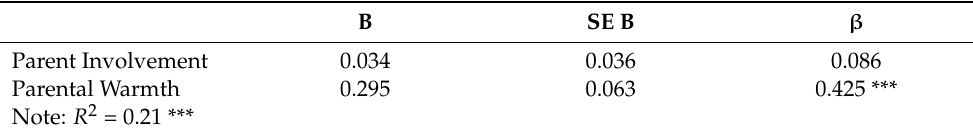
Table 5. Regression for girls—achievement.